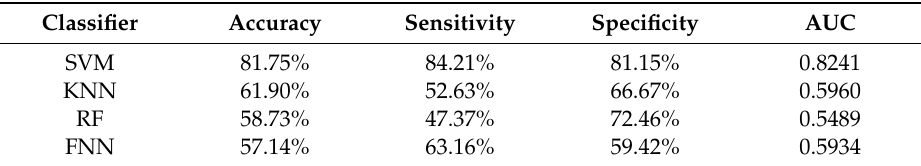
Table 3. Evaluation metrics of four di ff erent